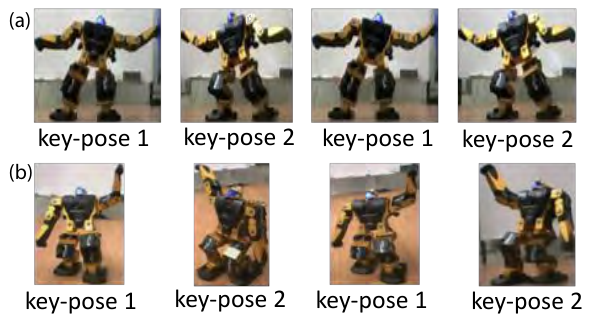
Figure 5: Key-poses of the two dance movements used in the quantitative and qualitative evaluations of the sys- tem: (a) mov1 ; (b) mov2